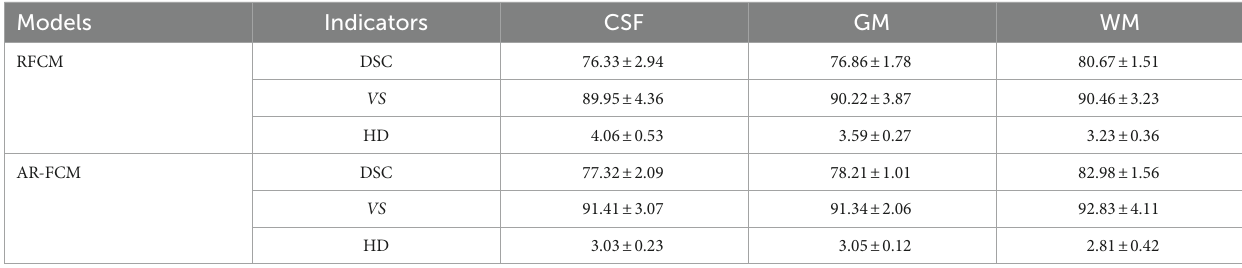
TABLE 4 Average DSC, VS and HD values for AR-FCM and RFCM.